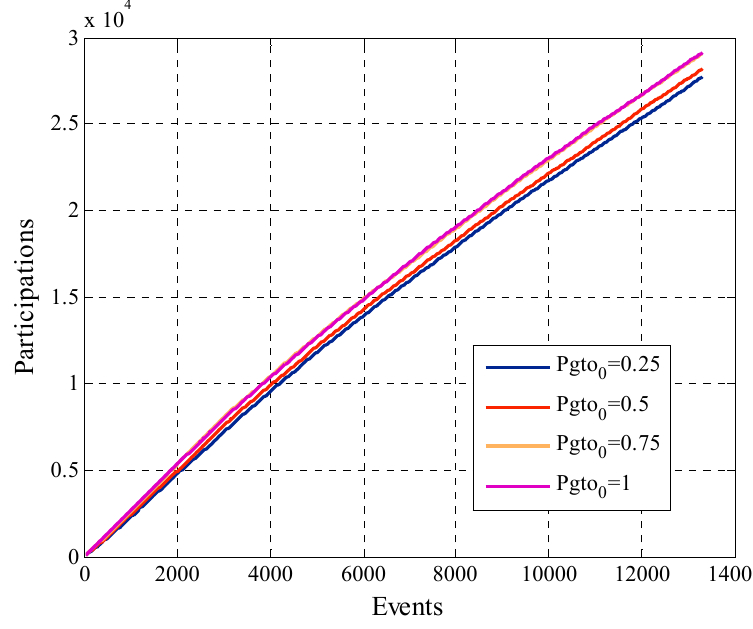
Figure 17. Platform utility for configurations with different values of 𝑃𝑔𝑡𝑜 (cid:2868) .